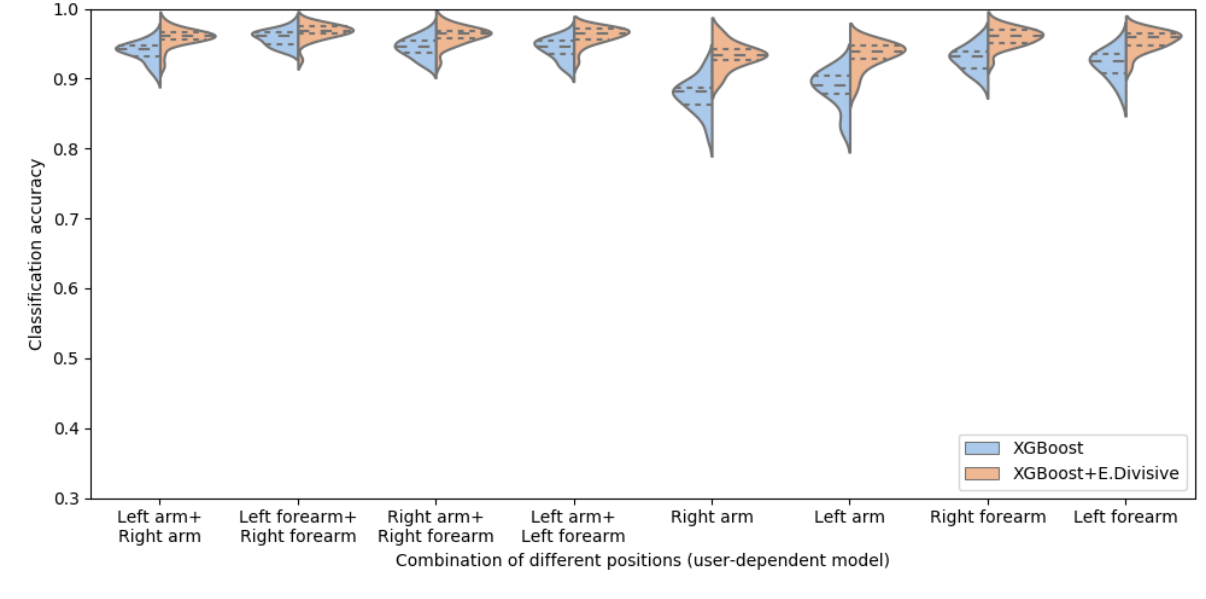
Figure 7. Classification accuracy of different combinations of armband positions: user-dependent